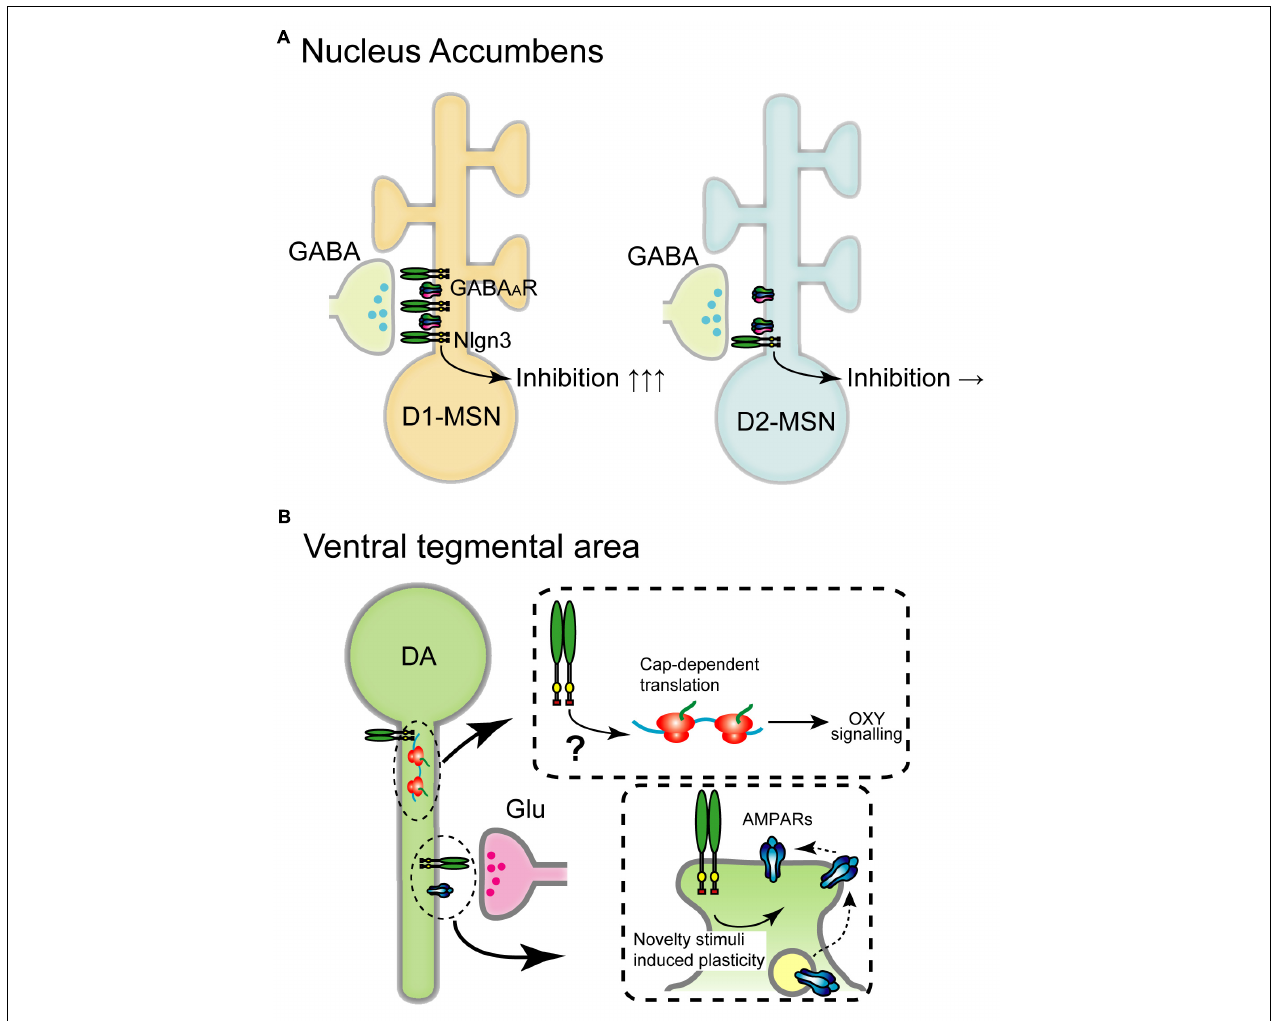
FIGURE 3 | Schematic diagram of the circuit-specific Nlgn3 functions in the mesolimbic pathway. (A) Cell type-specific expression of Nlgn3 in the nucleus accumbens. D1 receptor+ medium spiny neurons (D1-MSN, left) in the nucleus accumbens express higher levels of Nlgn3 than D2-MSNs (right) and regulate motor learning. (B) Nlgn3 function in the VTA. Nlgn3 expressed in DA neurons regulates cap-dependent translational machinery important for oxytocin (OXY) signaling (upper) (Hornberg et al., 2020) and activity-dependent GluR2-lacking AMPA receptor trafficking (lower) (Bariselli et al., 2018). GABA A R: GABA A